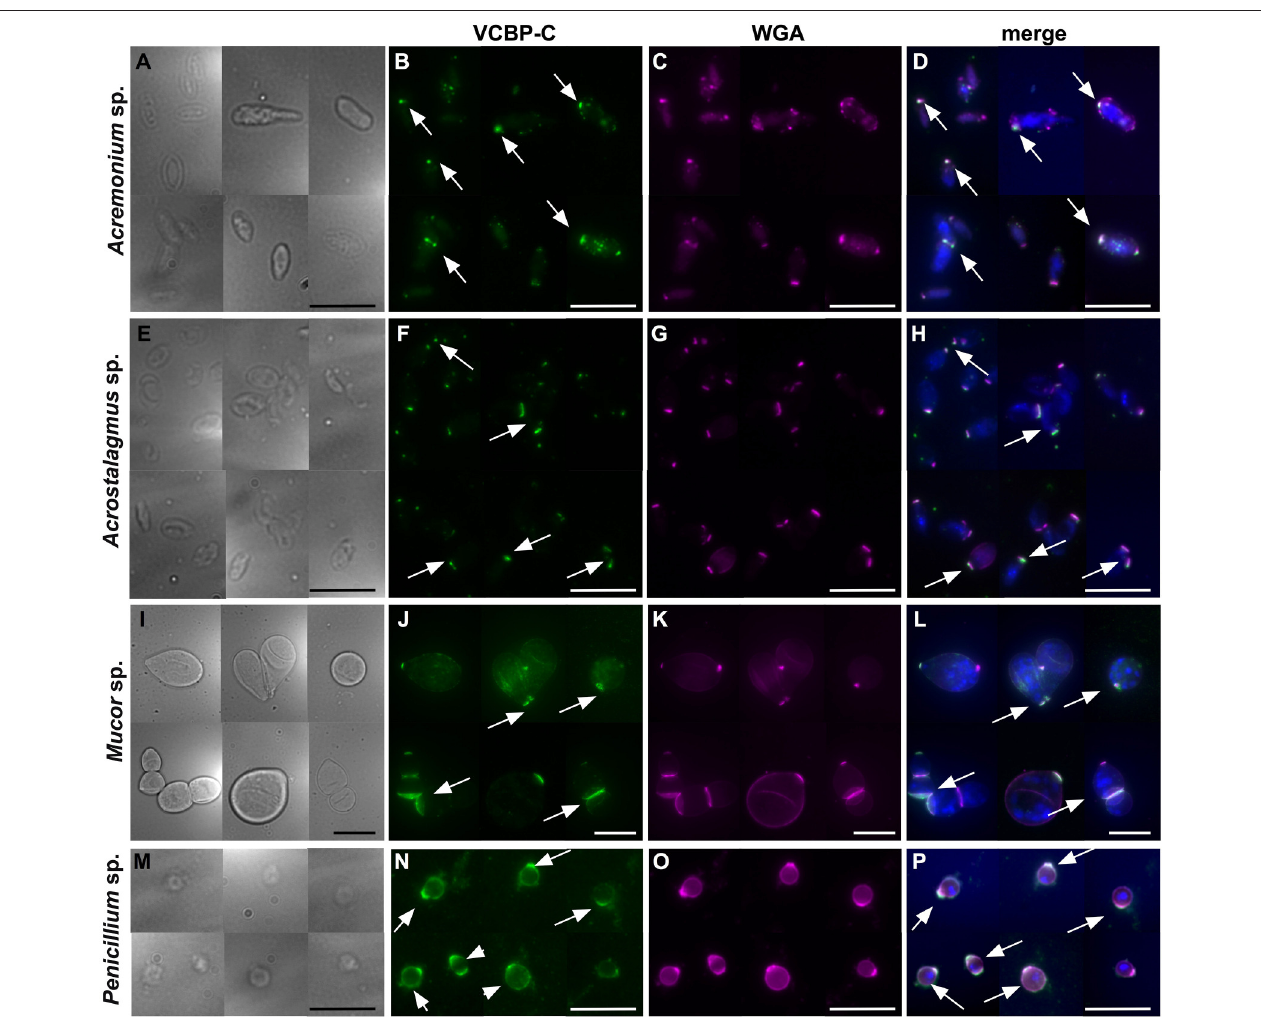
FIGURE 5 | Immunofluorescence on fungal spores incubated with VCBP-C protein and WGA. VCBP-C protein incubated with spores isolated from liquid cultures of Acremonium sp., Acrostalagmus sp. and Mucor sp. binds chitin localized in specific regions of the spore surface ( B,F,J , arrow). In Penicillium sp., VCBP-C recognizes chitin surrounding the entire spore ( N , arrowheads) or in some cases, localized to specific spots ( N , arrow). WGA staining (C,G,K,O) confirms the presence of chitin fibers on fungal spores. WGA co-localizes with VCBP-C staining in almost all of the spores, as observed in the merged images ( D,H,L,P , arrows). (A,E,I,M) represent brightfield images; (D,H,L,P) represent merged images: VCBP-C in green, WGA in magenta and nuclear staining with Hoechst in blue. Scale bars: 10 µ